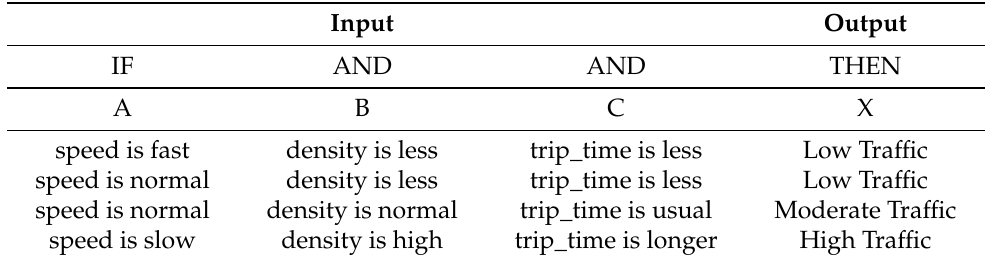
Table 3. FSI rule base for a traffic monitoring